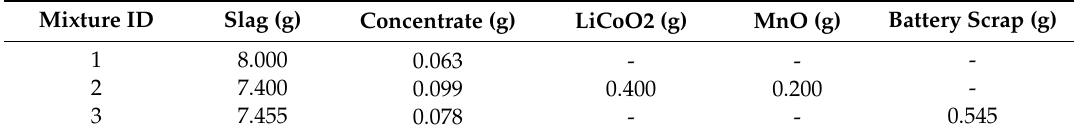
Table 3. Feed mixture weights for mixtures 1–3.